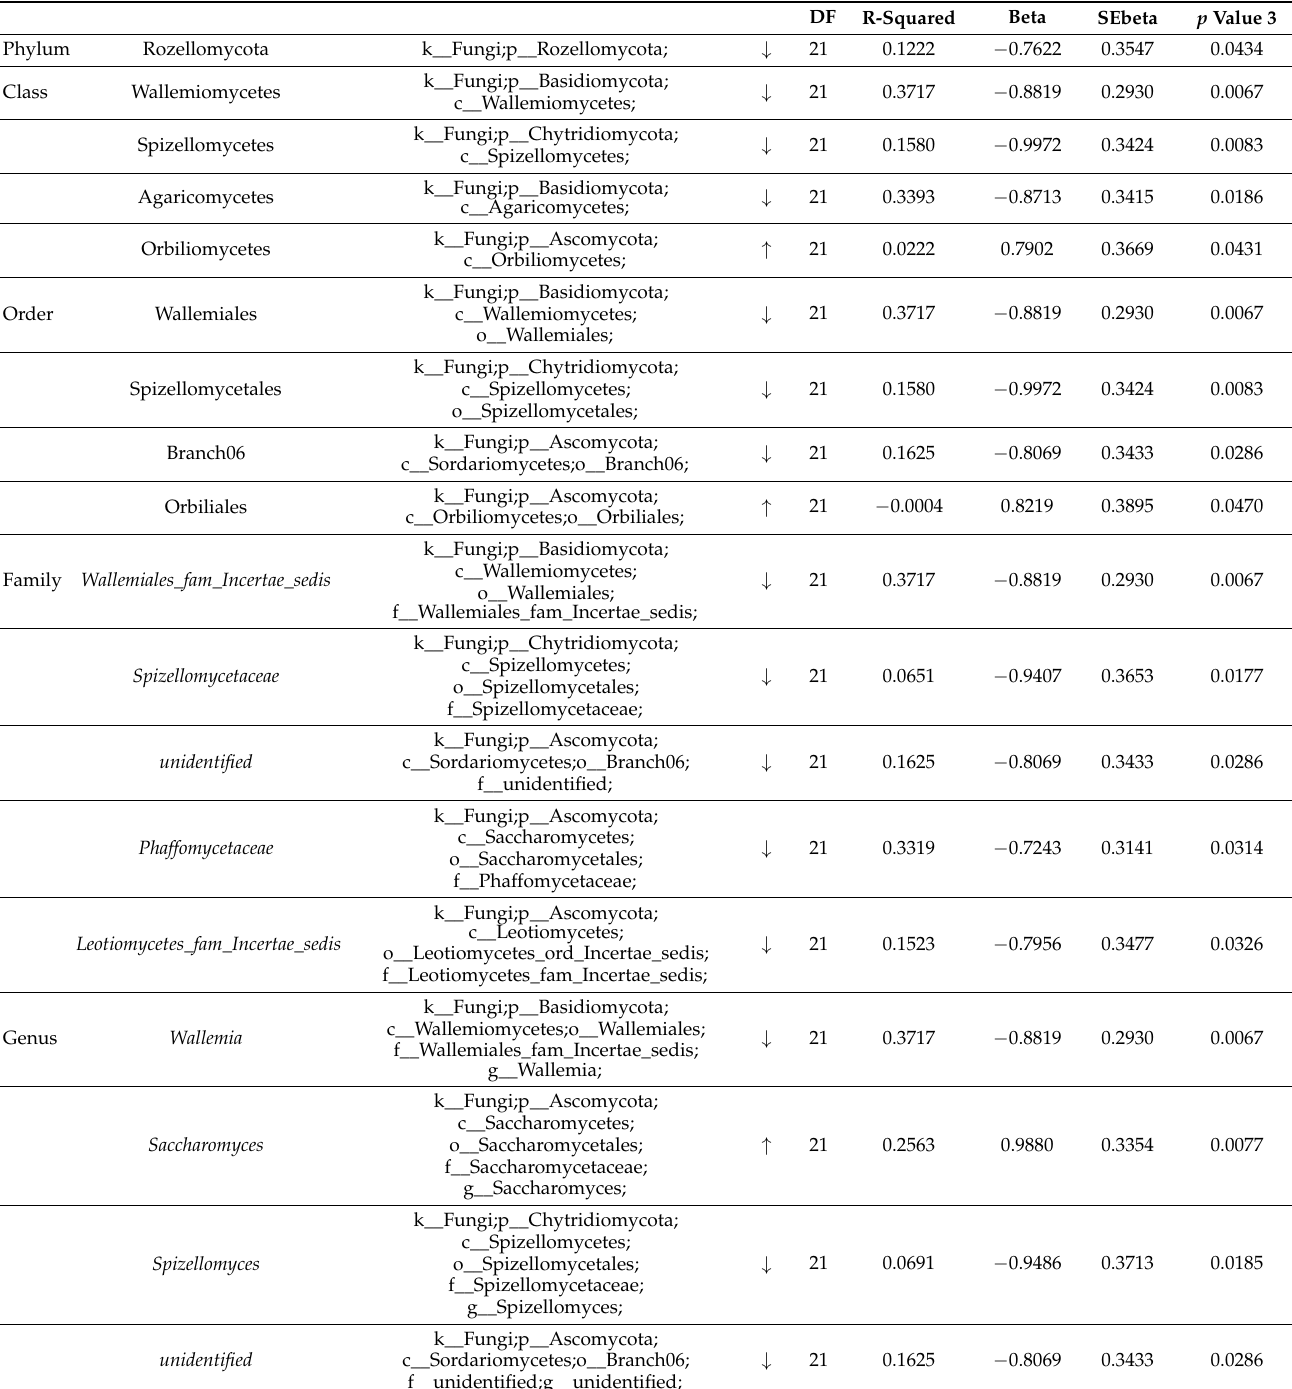
Table 8. Significant changes in Fungal abundance in NDD compared to